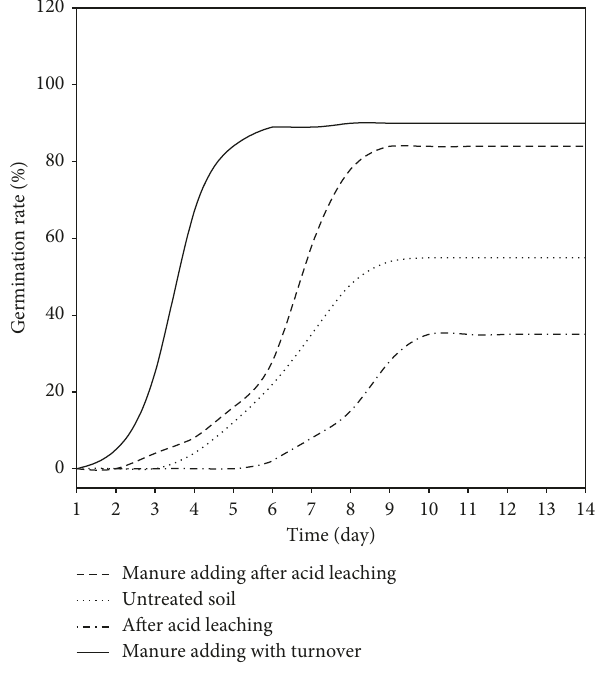
Figure 6: Seed germination rate as a function of time at various treatments. Table 2: Distribution of heavy metal concentration at the root and leaf of